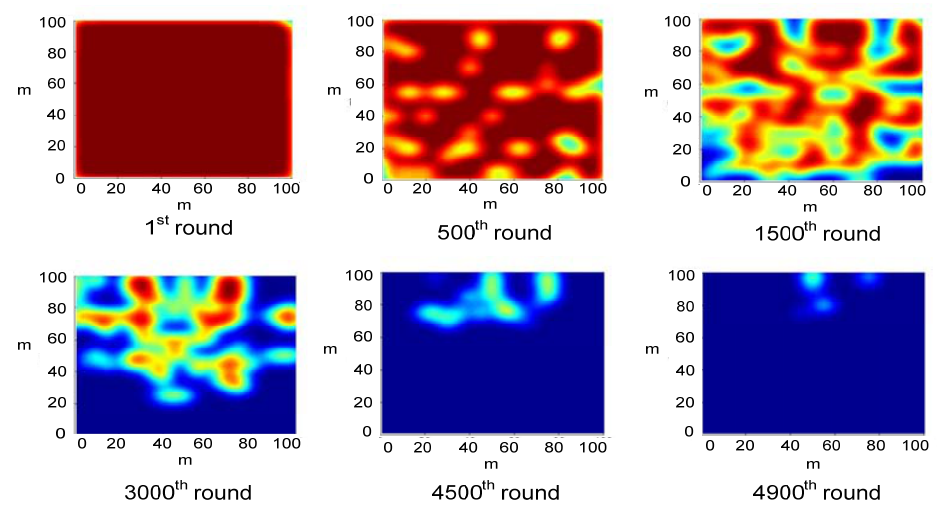
Figure 12. Spatial distribution of the remaining energy for the CWSN during simulation. The dark red regions indicate that the regions reserve more energy, and the dark blue regions preserve less remaining